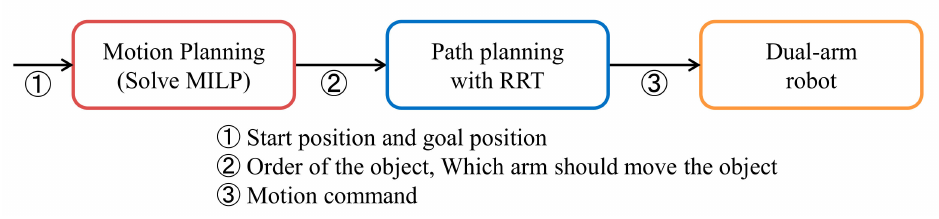
Figure 6. System chart in the experiment. MILP: mixed integer linear programming; RRT: rapidly exploring random tree.